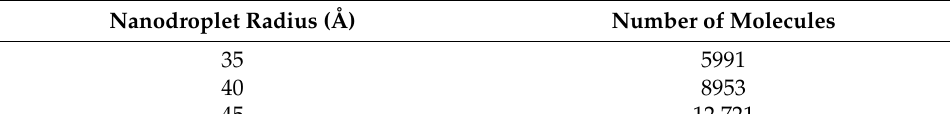
Figure 2. Density profile of the right-sided water nanodroplet on the smooth copper surface.